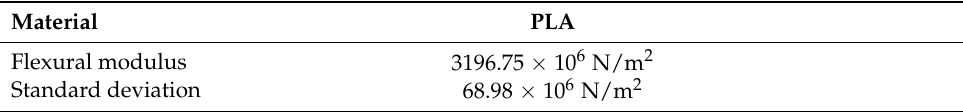
Figure 5. Schematic setup of the three-point bending test with dimensions (in mm). Table 4. Flexural modulus (static) of PLA according to DIN EN ISO